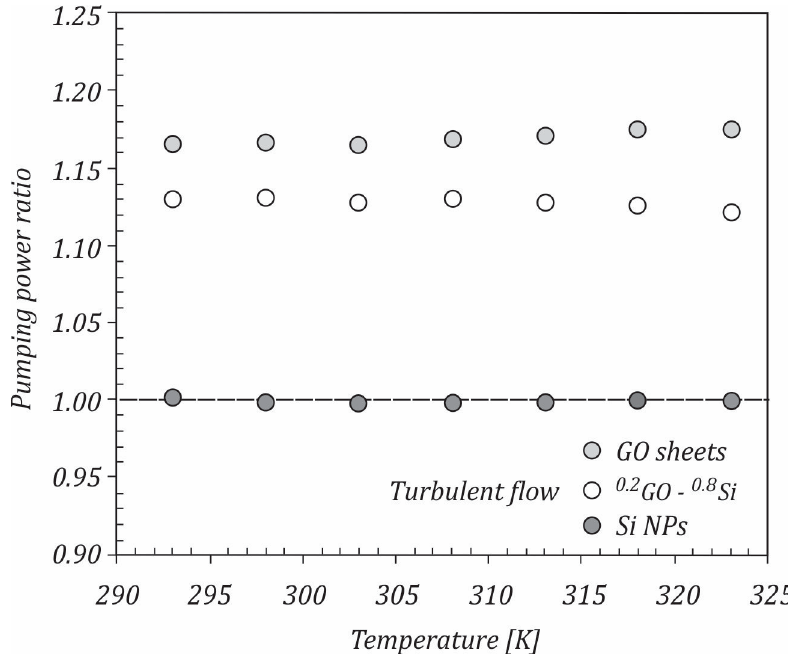
Figure 14. Pumping power variation with the